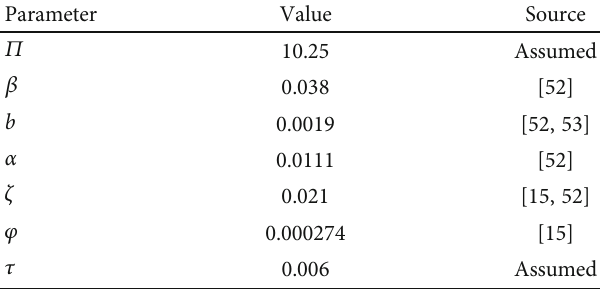
Table 1: Parametric values for our model